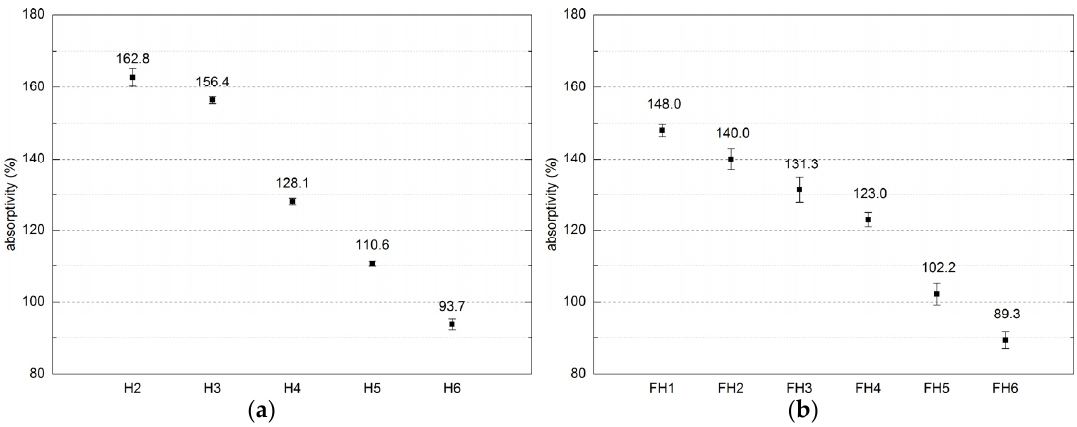
Figure 10. Mass absorptivity of composites (error bars mean standard deviation of absorptivity) : ( a ) Series 1, ( b ) Series 2.